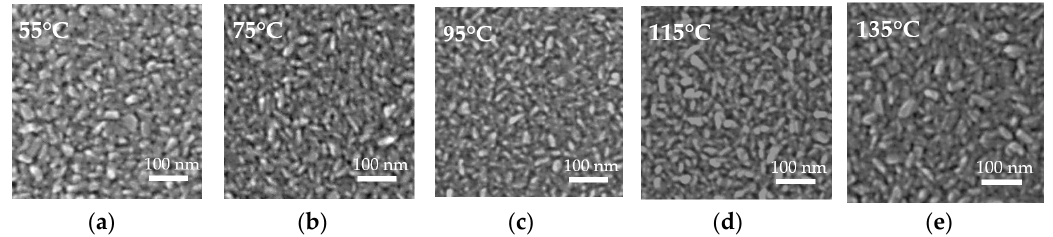
Figure 7. Field emission scanning electron microscopy (FESEM) images of sALD-ZnO films deposited at ( a ) 55 °C, ( b ) 75 °C, ( c ) 95 °C, ( d ) 115 °C, and ( e ) 135 °C.